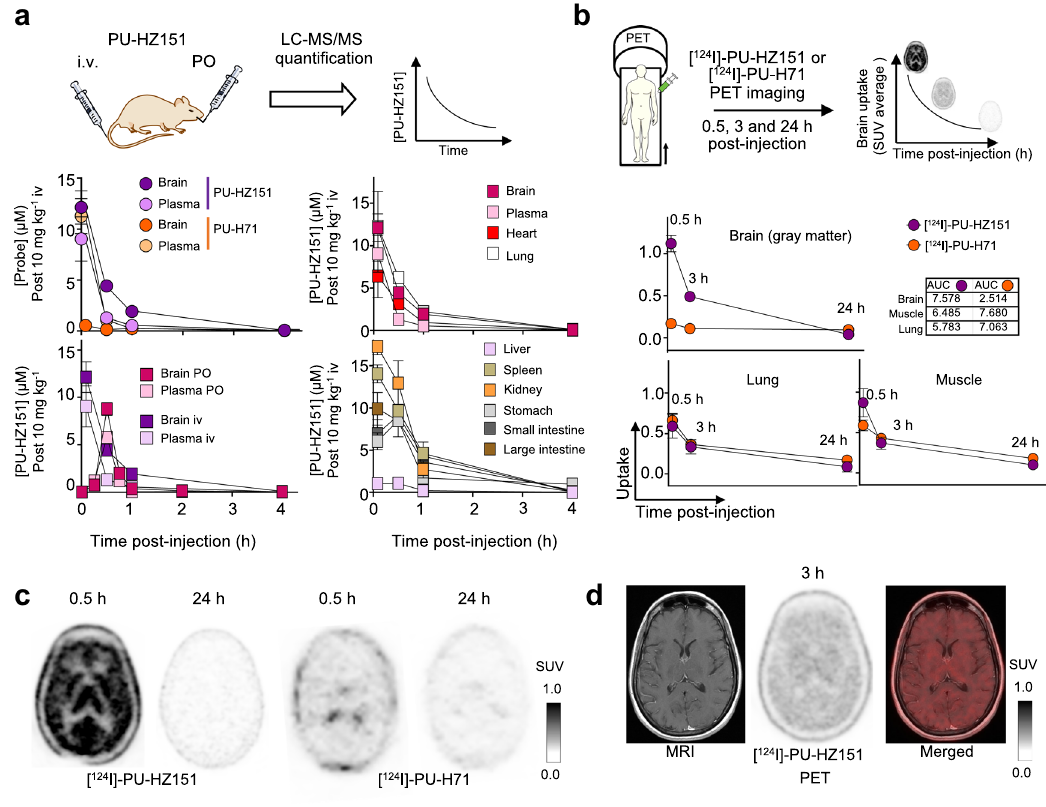
Fig. 2 Brain permeability of derivative 85, PU-HZ151, in mice and humans. a Time-dependent molar concentration curve of PU-HZ151 in plasma and brain determined by liquid chromatography-tandem mass spectrometry (LC-MS/MS). Non-CNS, metabolizing and non-metabolizing, organs as well as PU-H71 are shown for comparison. Probes were injected intravenously (i.v.) or by oral gavage (PO) at 10 mg kg − 1 to healthy male B6D2F1 mice ( n = 12 per experimental condition, 3 per time point). Data are presented as mean ± s.e.m. See also Supplementary Fig. 17. b Experimental design for positron emission tomography (PET) imaging in human patients. Images were obtained at 0.5, 3, and 24 h post [ 124 I]-PU-HZ151 or [ 124 I]-PU-H71 injection. non-CNS and non- Pgp organs and tissues are shown for reference. Graph, mean ± s.e.m. of n = 3 for [ 124 I]-PU-HZ151 PET and n = 14 at 0.5 h; n = 24 at 3 h and 24 h for [ 124 I]- PU-H71 PET. AUC area under the curve, SUV standard uptake value. c Representative axial brain PET images of normal (non-diseased) human brain obtained as in b at 0.5 and 24 h post [ 124 I]-PU-HZ151 single injection. PU-HZ151 demonstrates penetration across BBB, with no binding to neurologic structures and complete washout by 24 h. [ 124 I]-PU-H71 is shown for comparison. d A representative magnetic resonance imaging (MRI) overlaid with the PET image obtained at 3 h post [ 124 I]-PU-HZ151 injection shows the anatomic localization of PU-HZ151. Scale bars, PET window display intensity scales, with upper and lower SUV thresholds. Source data are provided as a Source Data fi